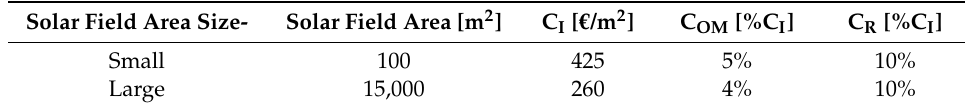
Table 5. LFC technology costs.